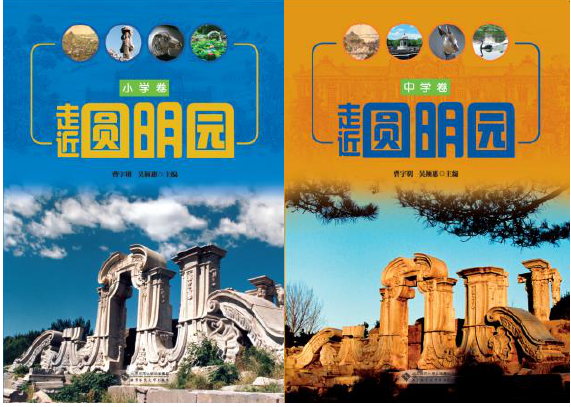
Figure 4. Covers of Close to Yuanmingyuan